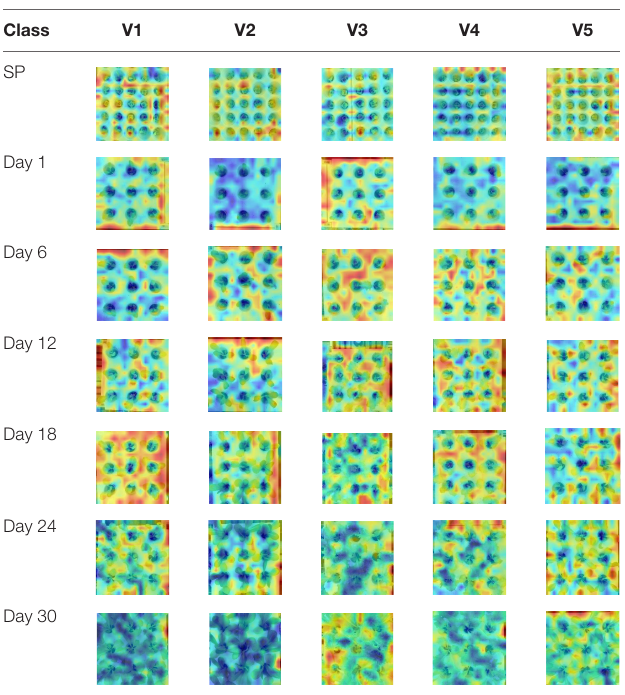
TABLE 6 | The class activation map (CAM) of